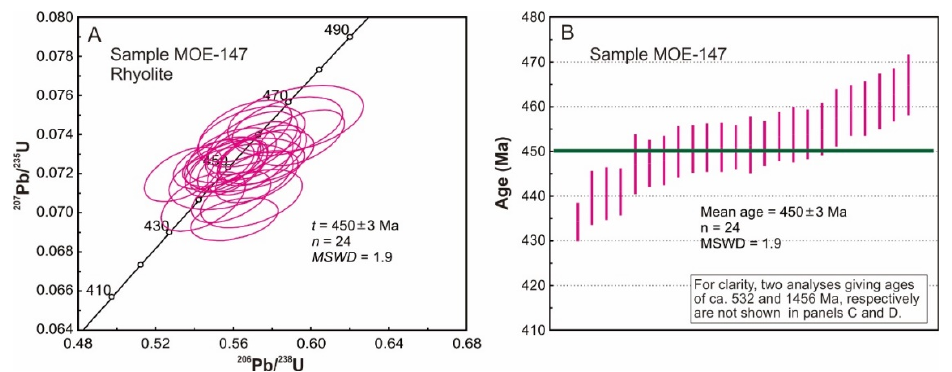
Figure 8. Zircon U-Pb data of a rhyolite sample MOE-147 from a ‘Vendian-early Cambrian’ volcanic suite on the Ereendavaa terrane in NE Mongolia. (A) Concordia plot and (B) Bar chart showing individual apparent ages and the weighted average (thick green line). Error ellipses in (A) and the error bars in (B) are at 1 σ level.